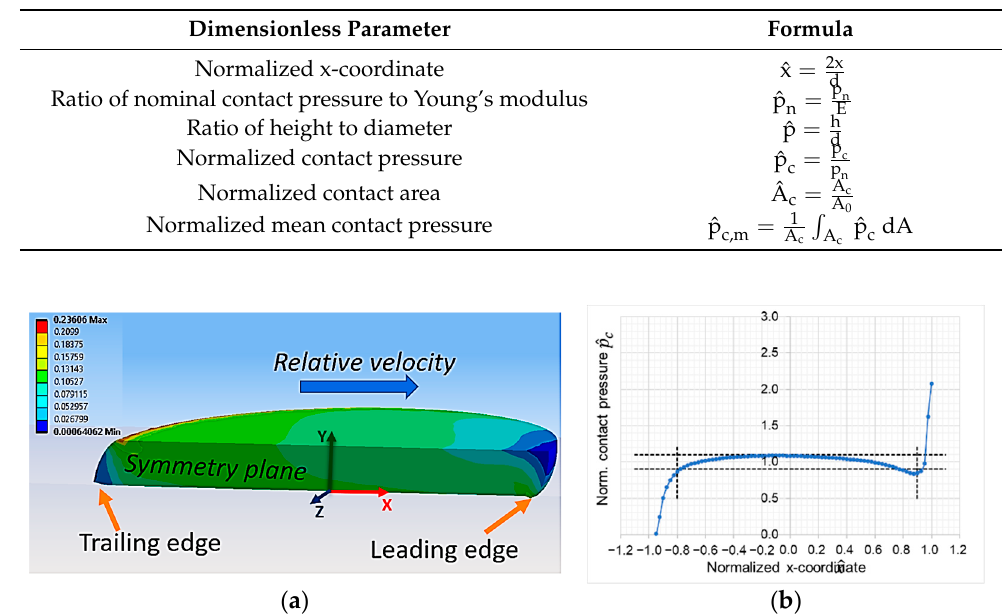
Figure 8. Variation of sample geometry ( a ) variation of height; ( b ) variation of diameter. Next, the influence of the sample load in terms of the nominal contact pressure and the polymeric material stiffness expressed in the Young’s modulus were investigated. Here, it can be observed that for both parameter variations the profile of the contact pres- sure shows no significant change (see Figure 9). However, for higher loads, the level of the normalized contact pressure decreases because of increased deformations of the pol- ymer. Likewise, lower Young’s moduli lead to higher lateral deformations and conse- quently to increased contact areas and lower contact pressures. Nevertheless, the influ- ence of these two parameters on the test conditions of the test appear to be rather small.